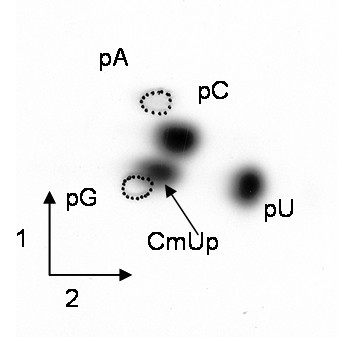
Complete RNAse T1 cleavage followed by nuclease T2 cleavage of in vitro transcribed E. coli tRNASer1 incubated with YfhQ and AdoMet. Autoradiography of a two-dimensional chromatogram of 5'-phosphate nucleosides on a thin layer cellulose plate. [α-32P]CTP-labelled in vitro transcribed tRNASer1 (1.5 × 106 cpm) was incubated with the YfhQ protein. The reaction mixture contained 50 mM PIPES-Na, pH 7.0, 4 mM MgCl2, 50 μM AdoMet and 5 μg of the purified YfhQ protein. After 90 min incubation at 37°C, the tRNA was recovered, digested overnight at 37°C by 400 u RNAse T1 in 100 mM Tris-HCl pH 7.5. The resulting oligonucleotides were separated on a 20% polyacrylamide gel (19:1) and revealed by autoradiography. Oligonucleotides were eluted from the gel and cleaved by nuclease T2. The resulting nucleotides were analyzed as described [38]. This image shows the TLC analysis for a 5-nucleotide long fragment (nucleotides 31–35).